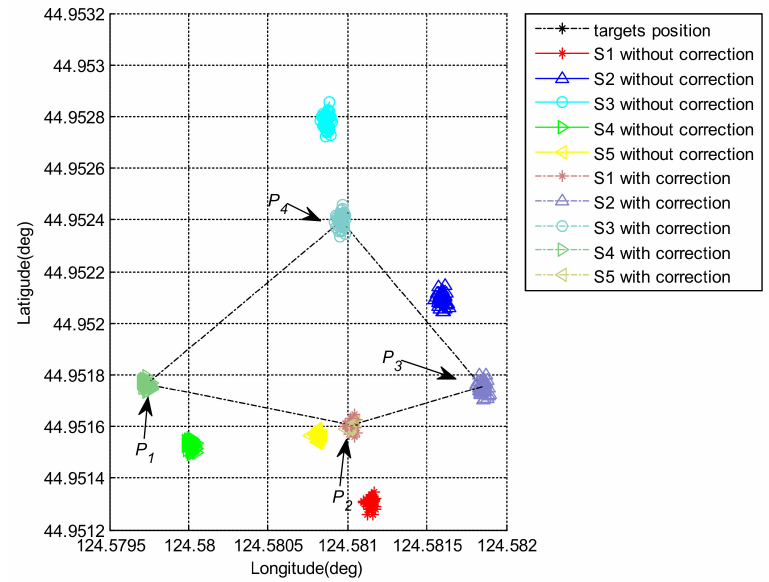
Figure 14. The computation results of the installing